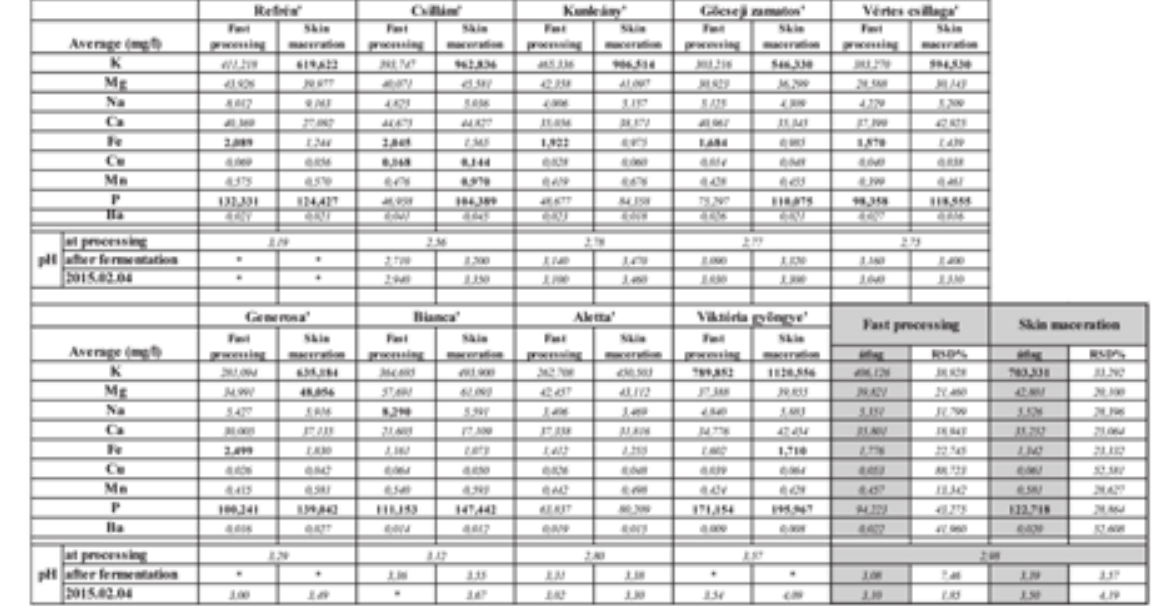
Table 4. Data on element composition of white wine varieties in respect to the application of skin maceration